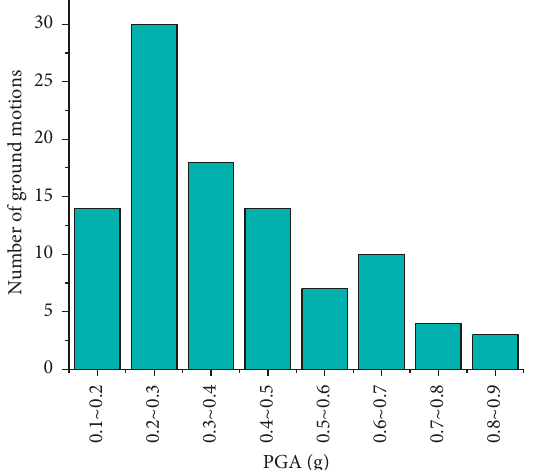
Figure 6: Distribution of PGA of the 100 ground